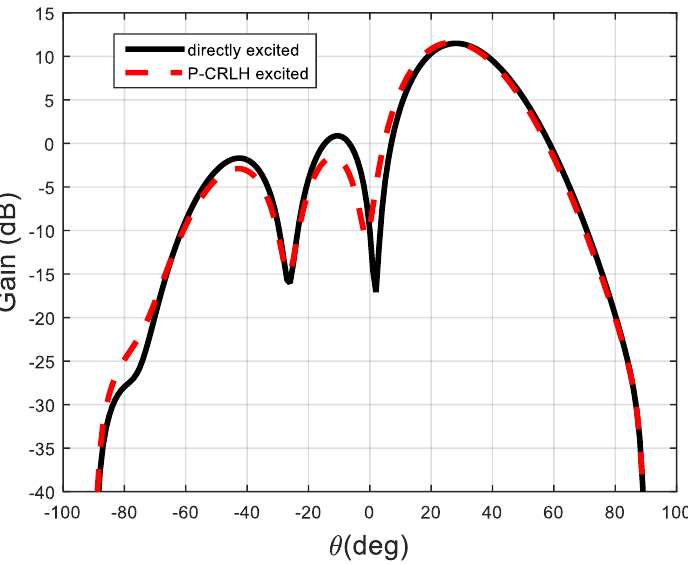
Figure 12. Simulated main beam at off-broadside 𝜃 0 = 30 ° with directly excited and P-CRLH-ex- cited phases. excited